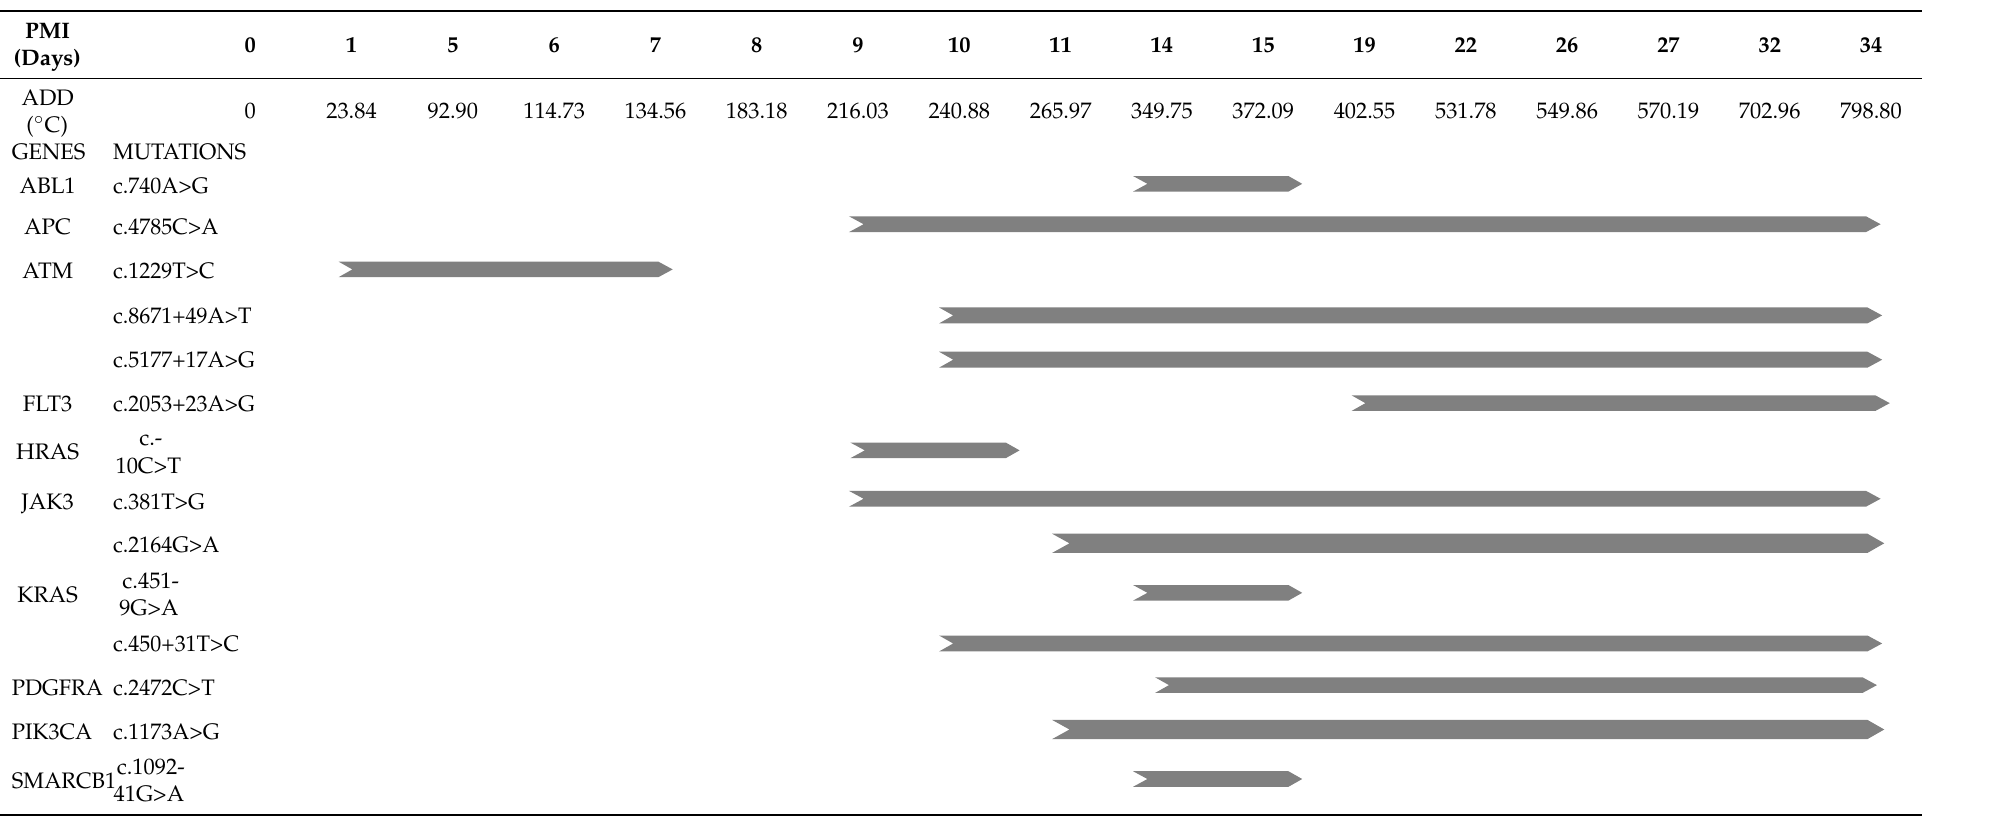
Dark-grey cells represent PMIs in which mutations were found. Moreover, Table 3 reports the mutations found only at specific PMIs.